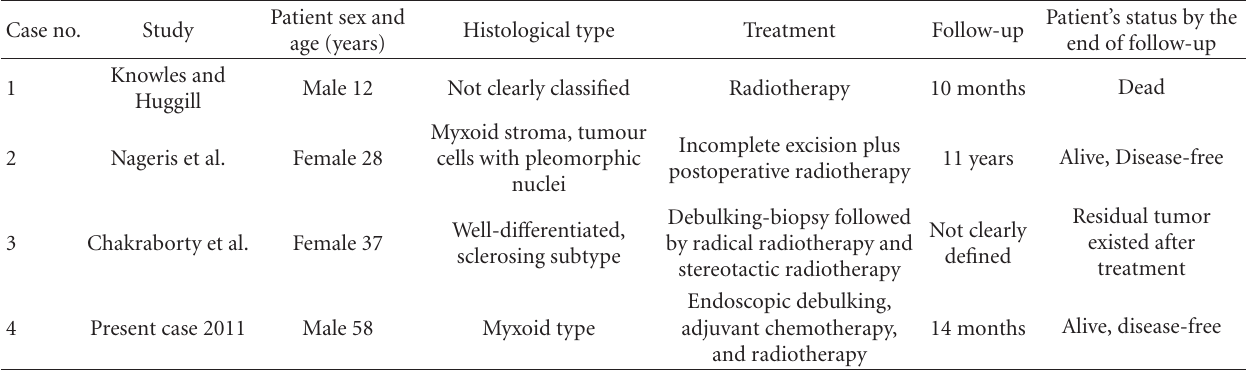
Figure 3: Histopathological images of the presented case. (a) Submucosal (surface epithelium in upper right) liposarcoma (H&E stain, × 25) (b) Myxoid liposarcoma, with lipoblastic di ff erentation (H&E × 100) (c) Liposarcoma with round cells (H&E × 100) (d) Mostly nuclear and some cytoplasmic immunoreactivity for S100 protein in the tumor cells ( × 100). Table 1: Cases of nasopharyngeal liposarcoma, reported in the English